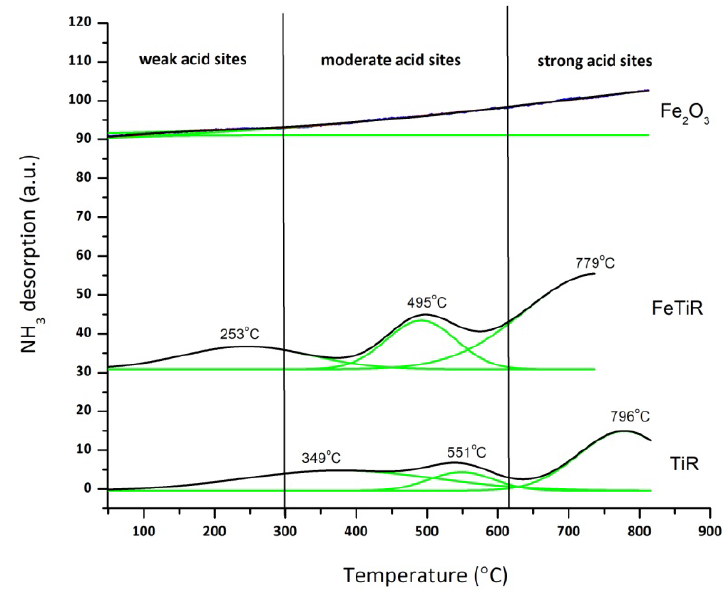
Figure 11. NH 3 -TPD profile. Table 3. The total acidity and distribution of the acid sites of the TiR, Fe 2 O 3 and FeTiR catalysts.